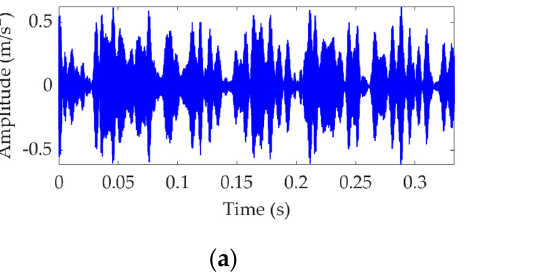
Figure 26. The optimal target mode: ( a ) time − domain waveform and ( b ) SES.